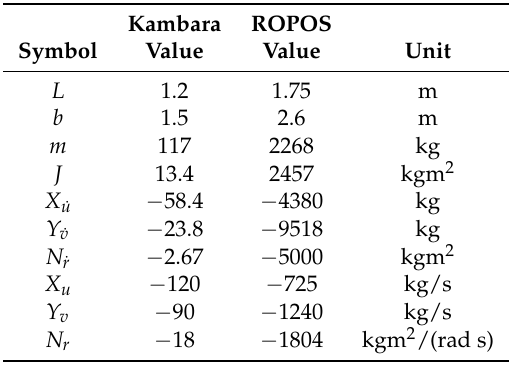
Table 1. Parameters of Kambara and ROPOS autonomous underwater vehicle